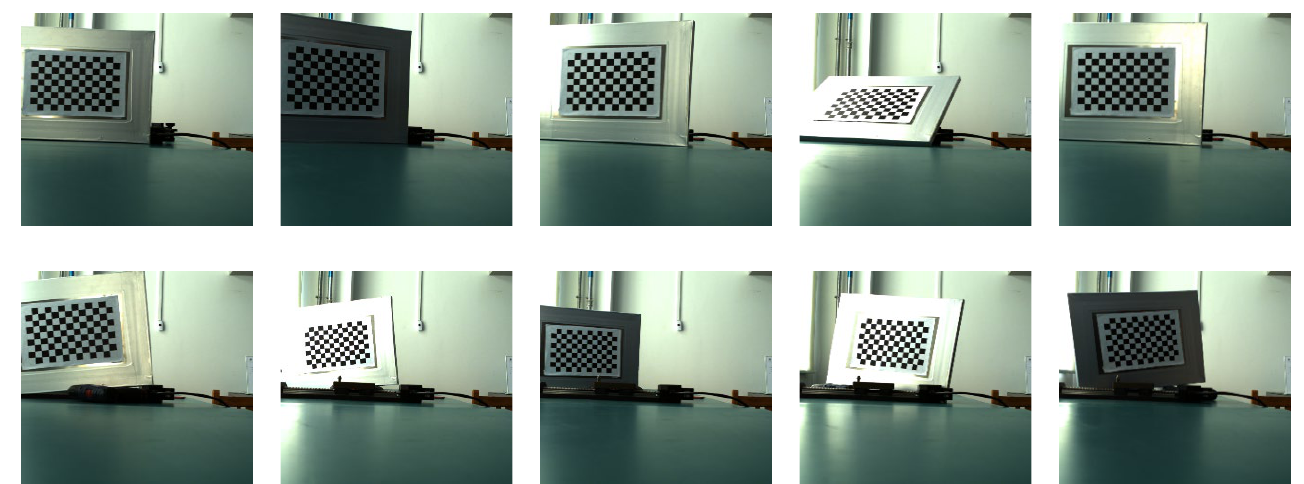
Figure 5. System calibration left view.